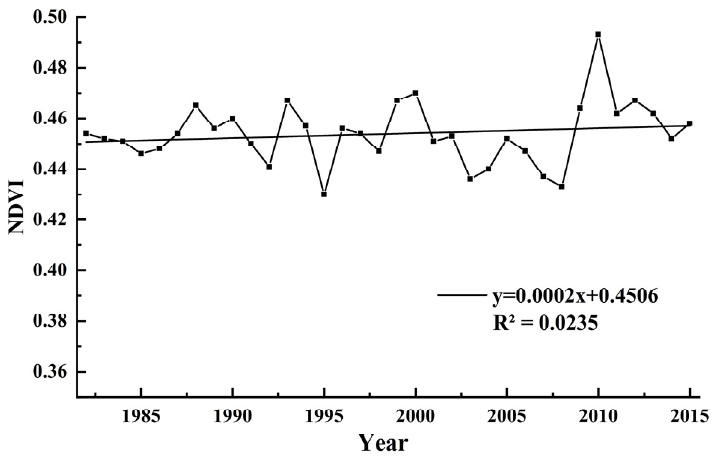
Figure 4. Change trend of the NDVI during 1982–2015 (The statistical significance level is 0.05).